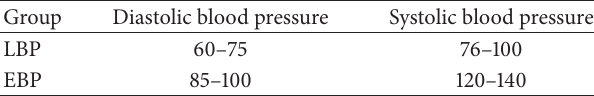
Table 1: Range of blood pressure (mmHg) in LBP and EBP groups.